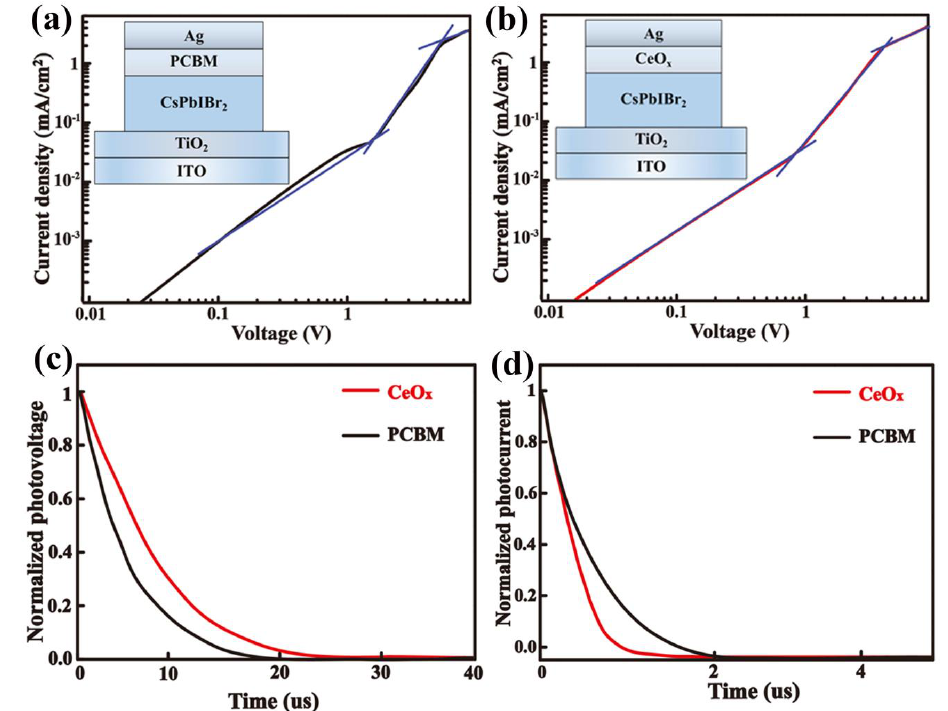
Figure 6. ( a ) The space-charge-limited current (SCLC) plot of ITO/ TiO 2 /perovskite/[6,6]-phenyl-C61-butyric acid methyl ester (PCBM) /Ag devices. ( b ) The SCLC plot of ITO/ TiO 2 /perovskite/CeO x/ Ag devices. ( c ) The transient photovoltage (TPV) decay curves. ( d ) The transient photocurrent (TPC) decay curves.